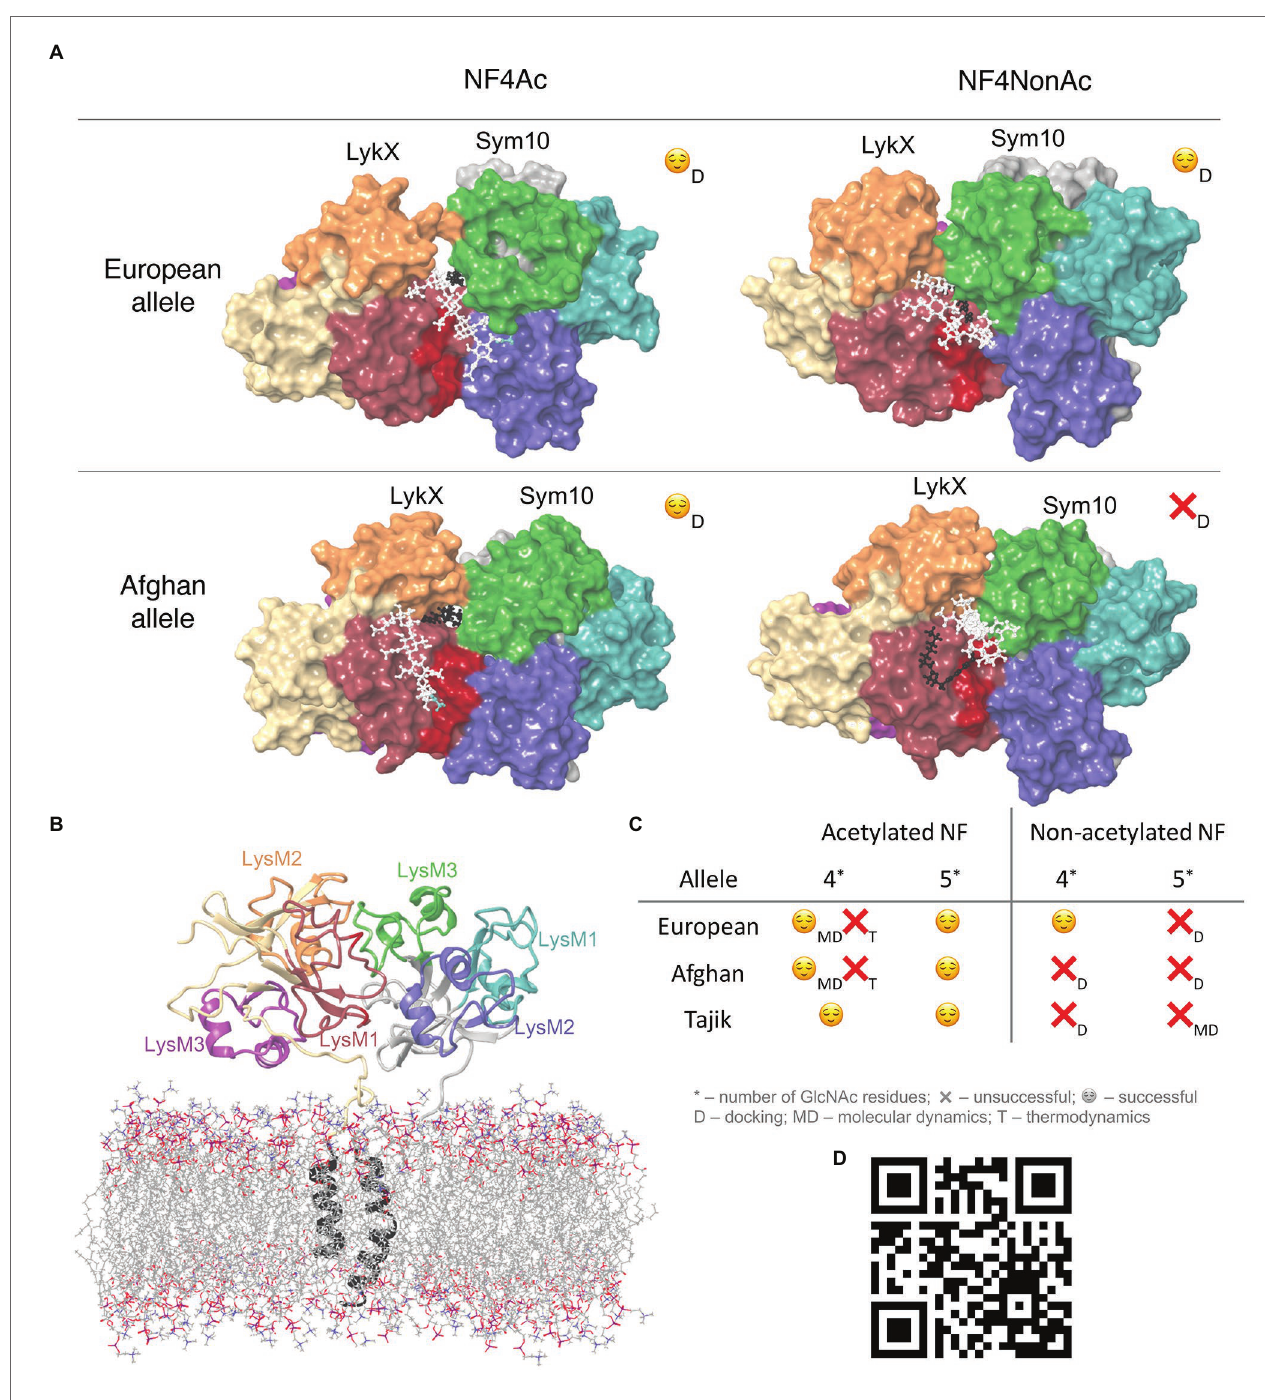
FIGURE 2 | (A) Four docking poses after docking. NFs core is colored with white, fatty tail – with black, and acetylation – with blue. (B) LykX-Sym10 dimer with transmembrane domains and membrane after 100 ns molecular dynamics (MD); (C) Table with successful and unfavorable NF-LykX-Sym10 complexes; (D) QR- code to the video with the MD simulation of the NF5Ac-LykX-Sym10 complex (Tajik alleles); NPT ensemble, 300 K, 500 ns, TIP4P water molecules are